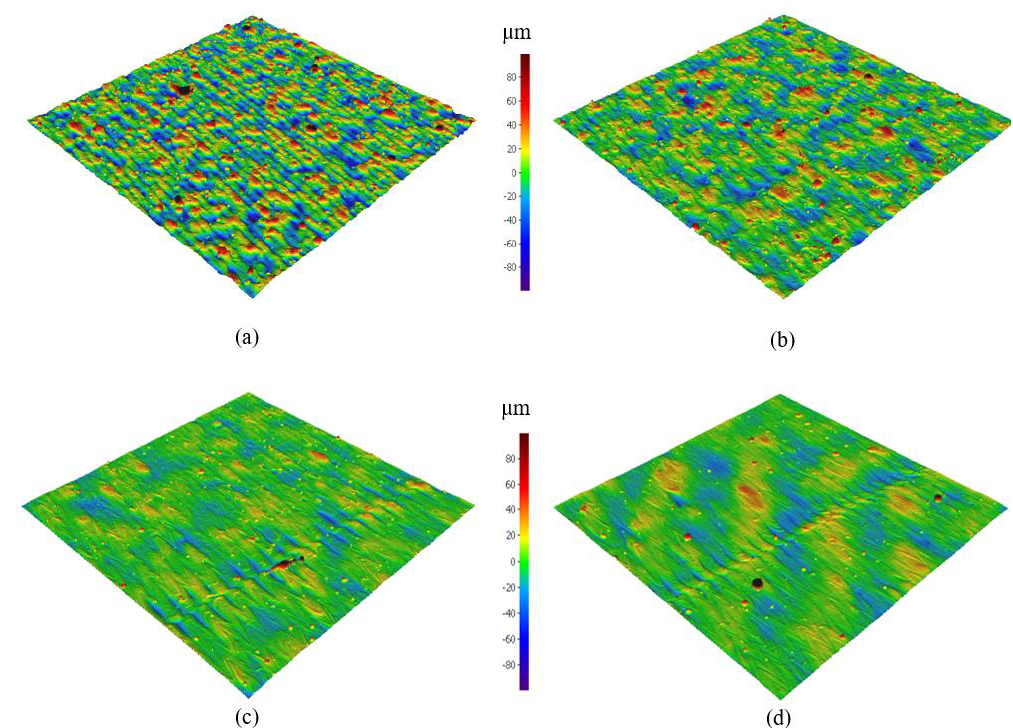
Figure 12. 3D surface texture of the as-built Al6061 samples; ( a ) 8A, ( b ) 6A, ( c ) 14A, and ( d ) 11A.